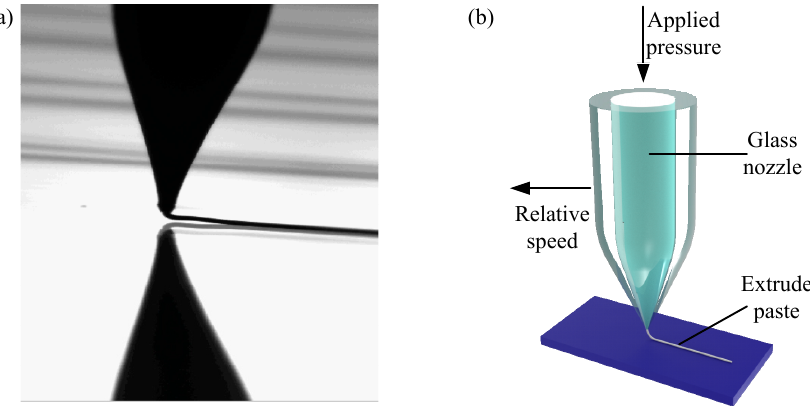
Figure 4. ( a ) Industrial camera real image of the printing process. ( b ) Schematic diagram of the paste printing model.